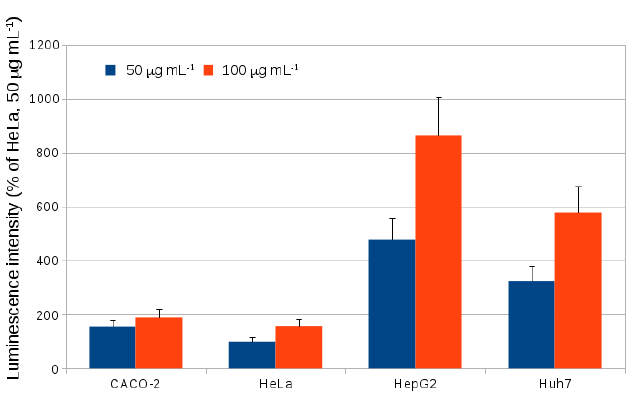
Figure 11. Luminescent intensities in excess of the background from the control (HeLa, no SiQDs present) measured using flow cytometry (excitation 355 nm, emission 675 nm) for cells treated with 50 or 100 µ g mL − 1 SiQD for 24 h. The values reported are normalized to the intensity for HeLa treated with 50 µ g mL − 1 SiQD for 24 h. Bars are means ± SD for n = 3